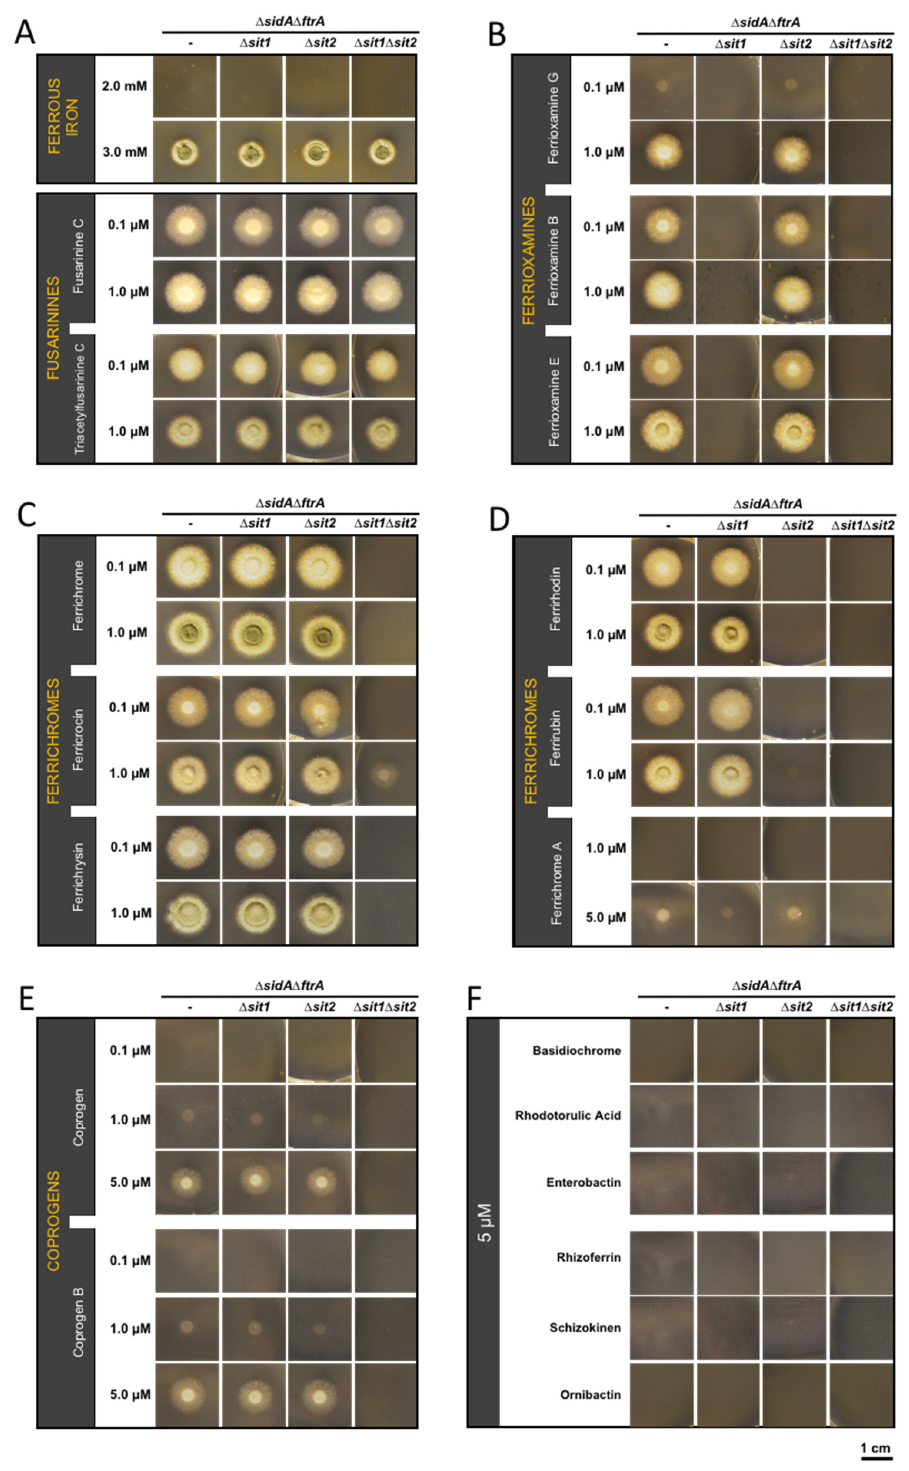
Figure 1. A. fumigatus Sit1 and Sit2 mediate utilization of ferrioxamine-, ferrichrome-, and coprogen- type siderophores. To analyze the role of Sit1 and Sit2 in the utilization of endogenous and exoge- nous siderophores, 1 × 10 4 conidia of the mutant strains were point-inoculated on solid minimal medium supplemented with different concentrations of Fe 2+ or ferric siderophores: ( A ) Fe 2+ and fusarinine-type siderophores; ( B ) ferrioxamine-type siderophores; ( C , D ) ferrichrome-type sidero- phores; ( E ) coprogen-type siderophores; and ( F ) other siderophore-types. The plates were incubated at 37 °C for 48 h.